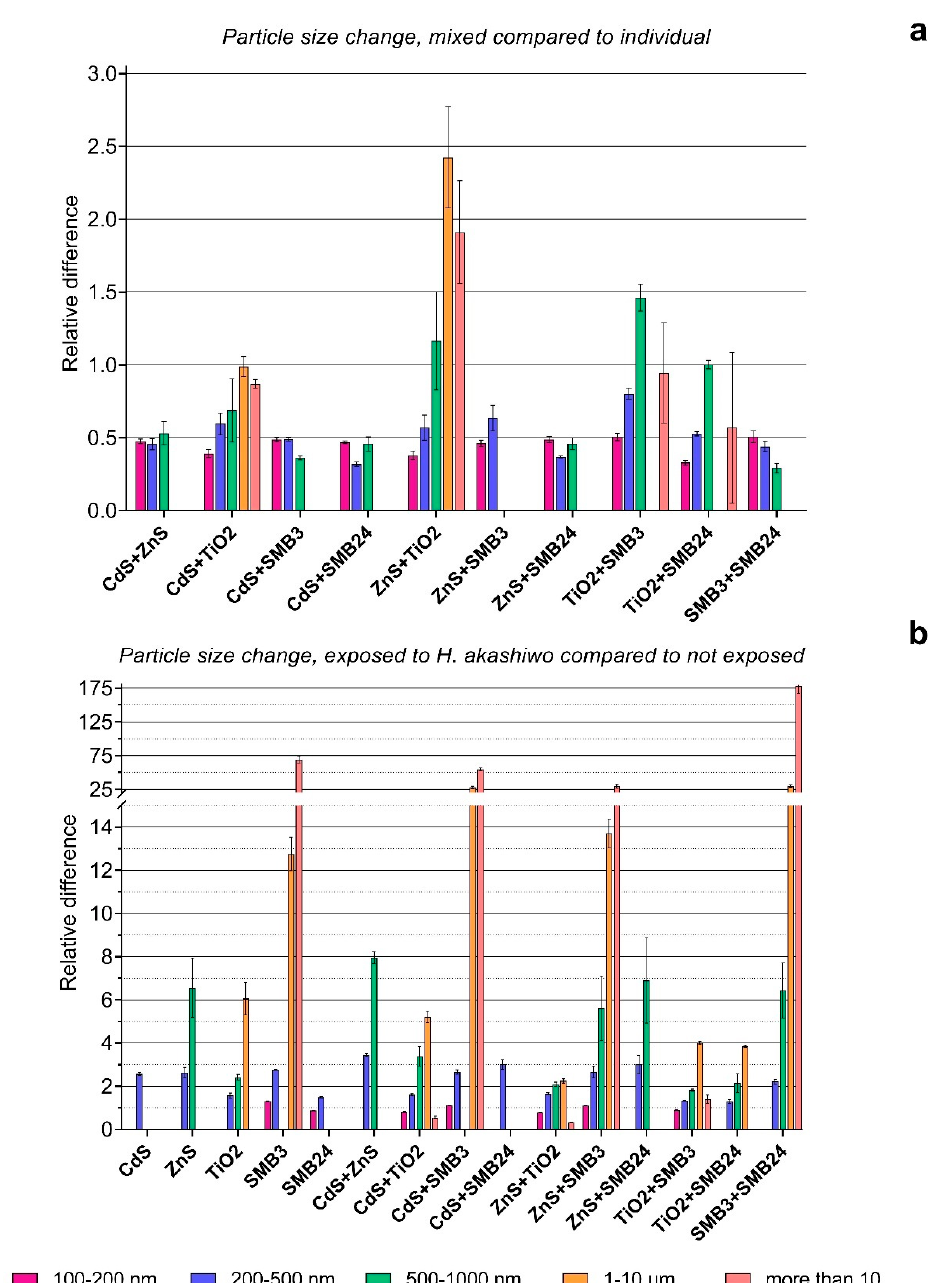
Figure 5. Effects of binary mixtures and presence of H. akashiwo on the size of the NPs. ( a ) Relative particle size change in binary mixtures compared with the sum of individual NPs after 96 h. ( b ) Relative particle size change after 96 h of exposure with H. akashiwo compared with 96 h of exposure without H. akashiwo . The values higher than 1.0 mean surpassing the experimental group compared with the reference group, and the values below 1.0 mean the corresponding reduction of the experimental group compared with the reference group (the lower value, the higher the reduction). Statistically insignificant results ( p > 0.05) are not represented on the graphs.